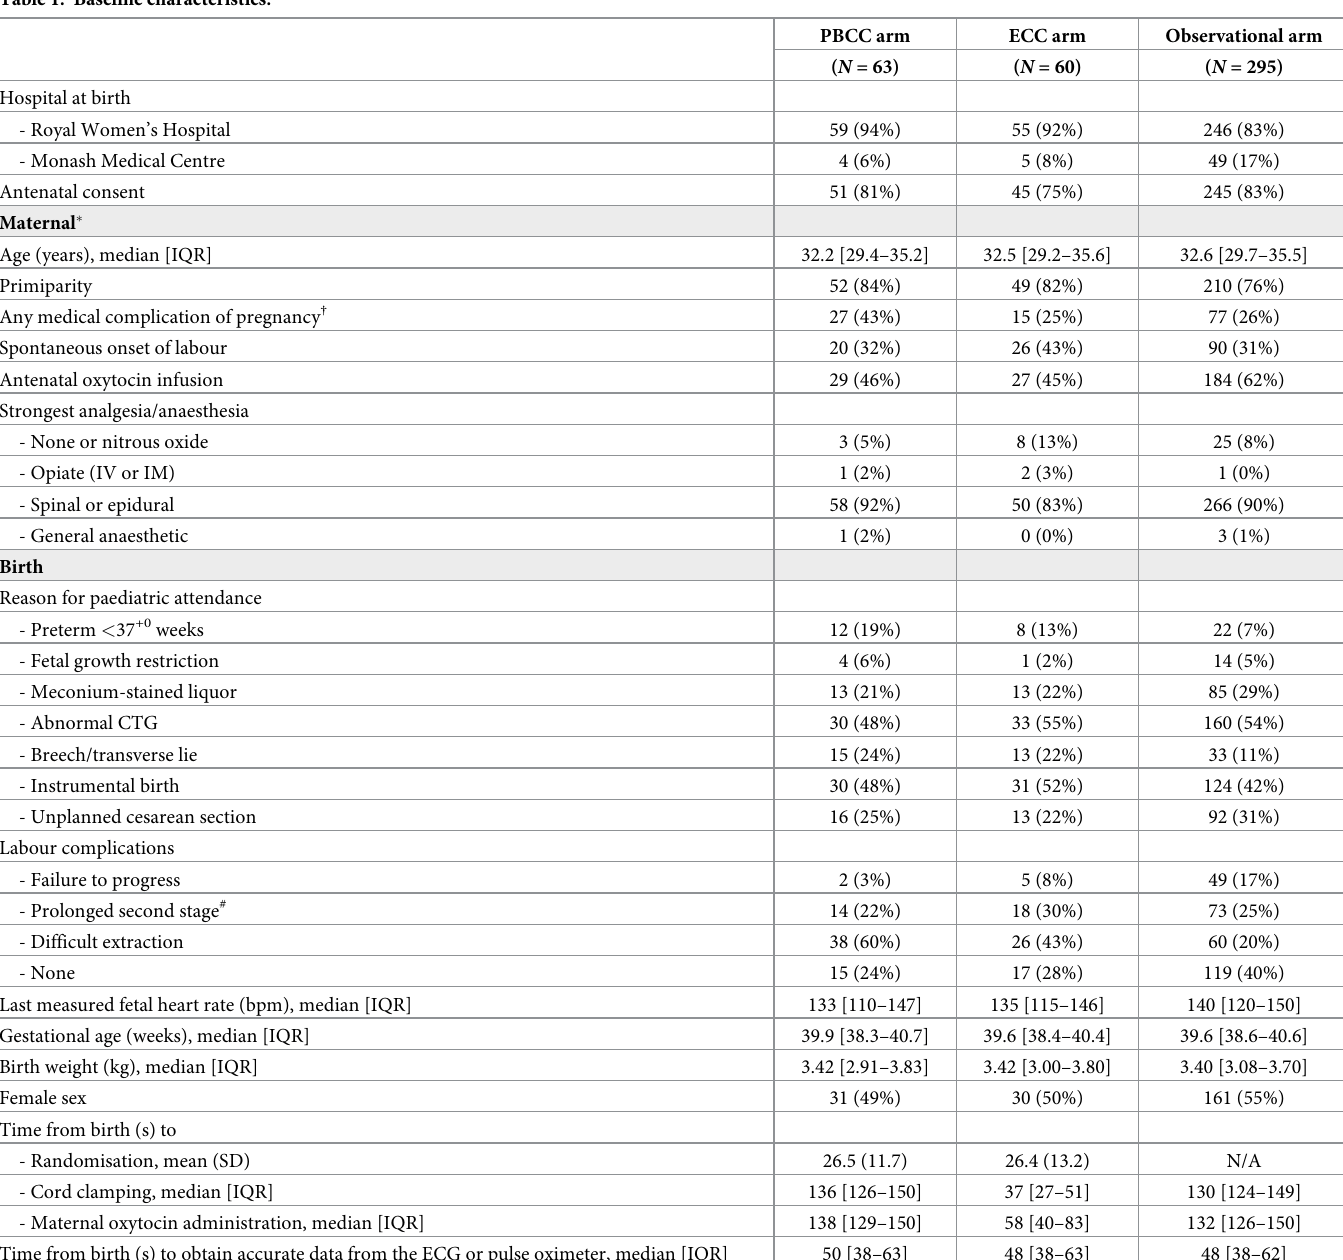
Table 1. Baseline